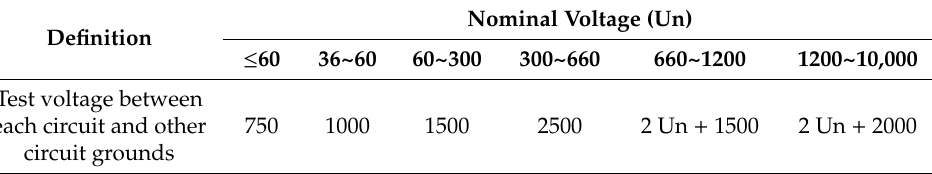
Table 3. Voltage insulation test for railroad applications.